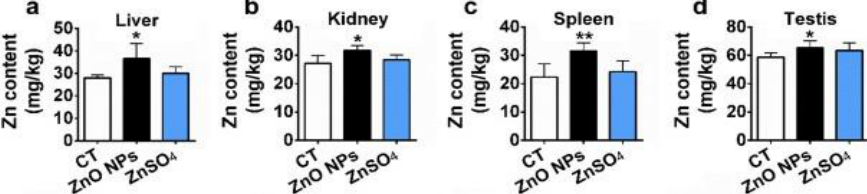
Figure 38. Zn accumulation in target organs of rats exposed intranasally to ZnO NPs with a single dose of 2.56 mg Zn per rat. A same dose of ZnSO 4 or sodium carboxymethyl cellulose solution (CT, control) was treated to the rats. Data are expressed as mean ± SD (n = 10). * p < 0.05 and ** p < 0.01 imply significant di ff erence compared with CT. Reproduced from [183] under the Creative Commons Attribution